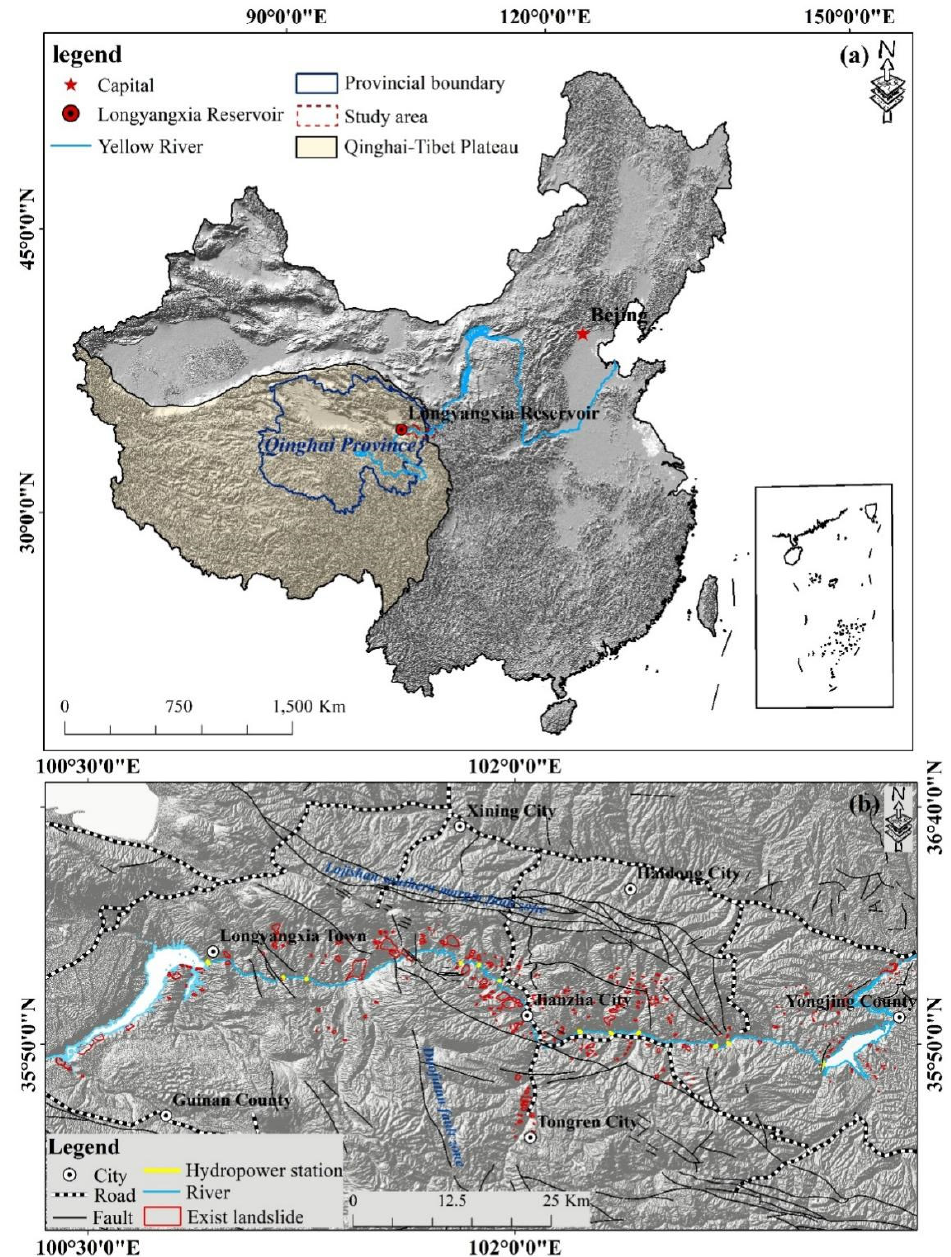
Figure 1. ( a ) Geographical location of Longyangxia Reservoir in China. The red solid line is the border of Qinghai Province, the blue shaded area is the Qinghai–Tibet Plateau, and the red triangle is the location of Longyangxia Reservoir. ( b ) Geological disasters, faults, and hydropower stations in the upper reaches of the Yellow River.